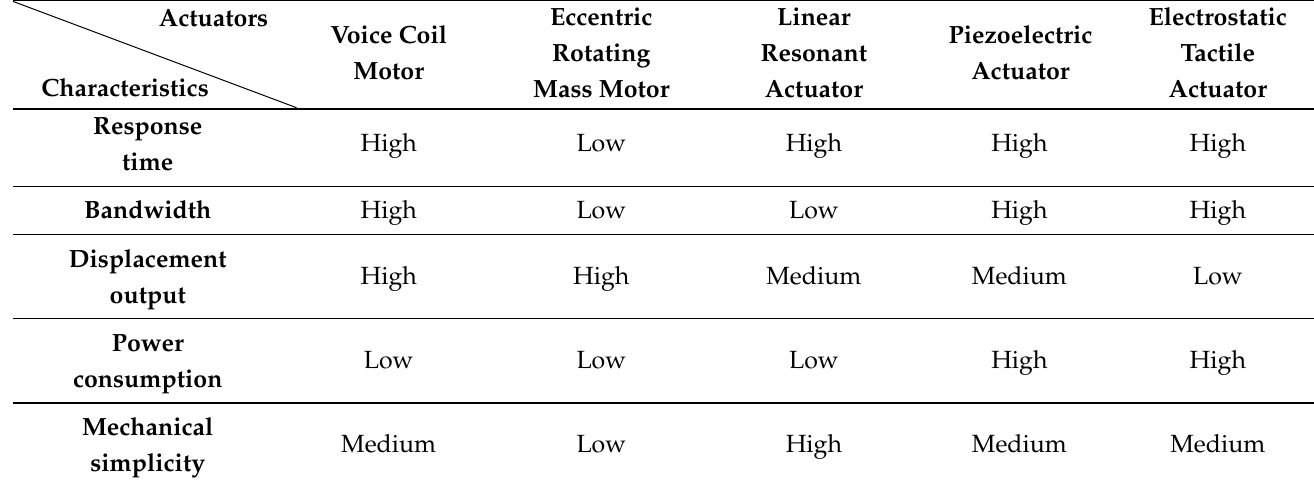
Table 1. Comparison of actuators and needed characteristics for haptic